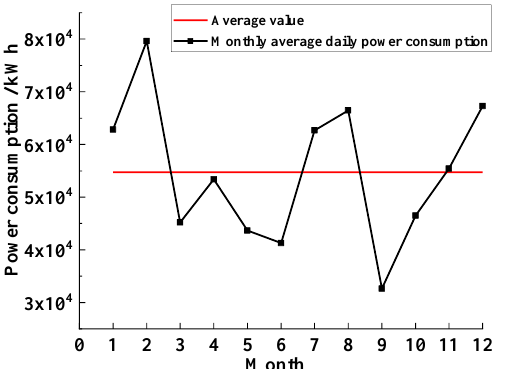
Figure 4. Monthly average daily power consumption of the home hotel